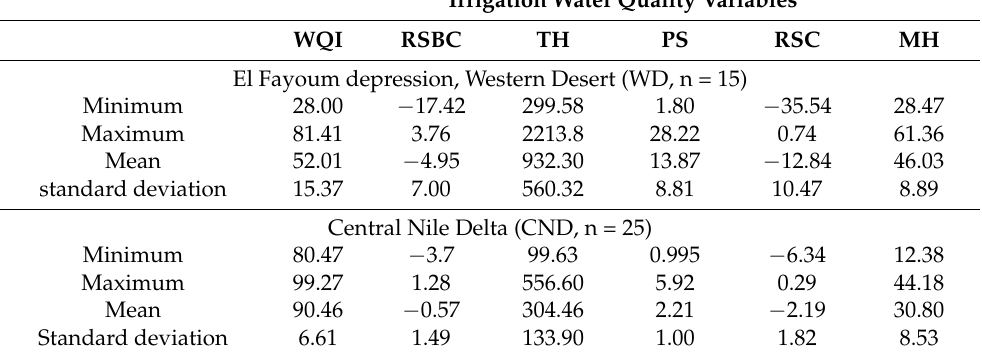
Table 3. Statistical description of different irrigation water quality indices including water quality index (WQI), residual sodium bicarbonate (RSBC), total hardness (TH), potential salinity (PS), residual sodium carbonate (RSC), and magnesium hazard (MH) of groundwater samples collected from the Western Desert and Central Nile Delta. Irrigation Water Quality Variables WQI